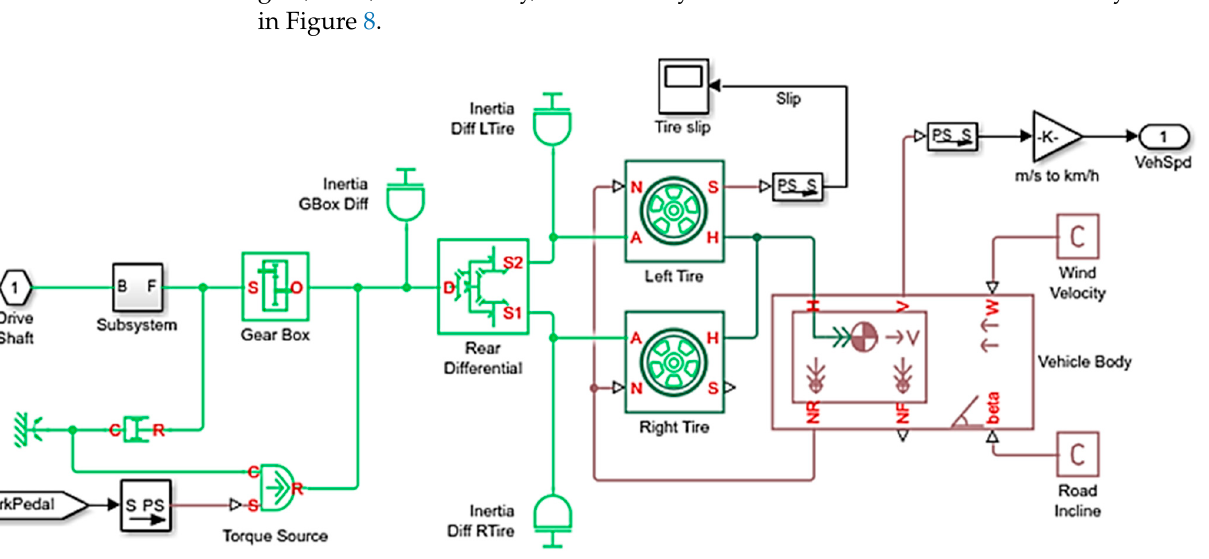
Figure 8. Model of HEV body .